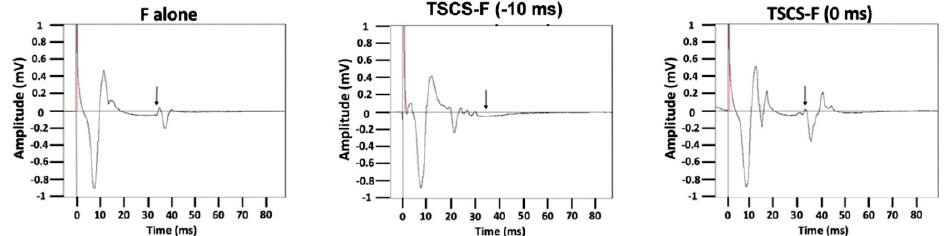
Figure 3. Suprathreshold TSCS collides with or facilitates F-wave responses depending on timing. Supramaximal median nerve stimulation was delivered to generate F-wave responses. Conditioning TSCS pulses at 175% of RMT were timed to arrive at cervical motor neurons either 10 ms prior to or simultaneously with retrograde median nerve pulse